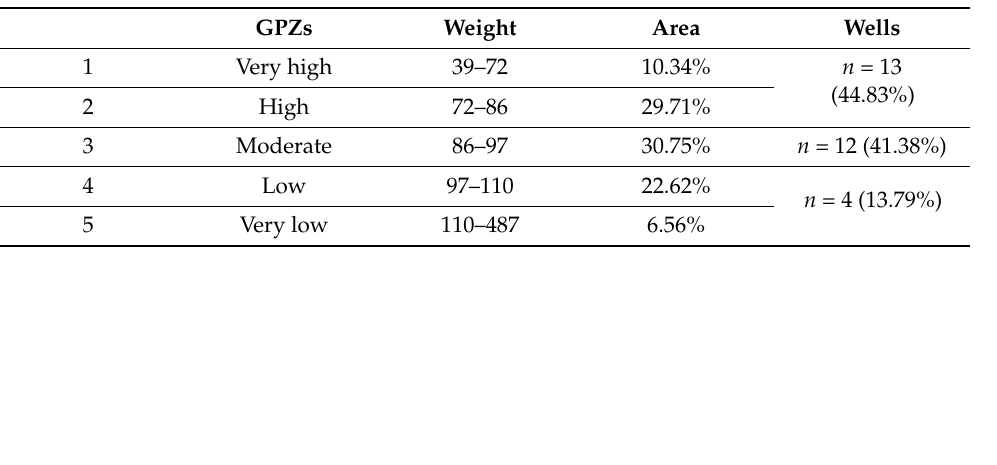
Table 4. GPZs of the present